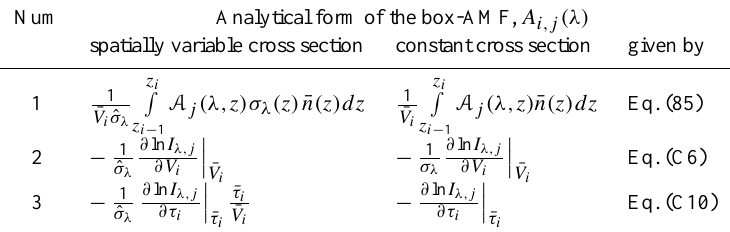
Table 3. Expressions for the box-AMF appropriate to the WFDOAS equation, Eq. (86). Num Analytical form of the box-AMF, A i,j (λ) spatially variable cross section constant cross section given